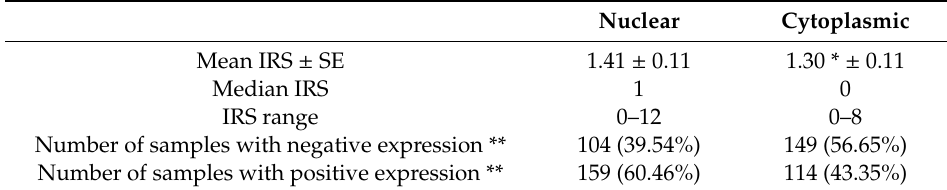
Table 2. Distribution of thyroid hormone receptor β 1 (THR β 1) expression.